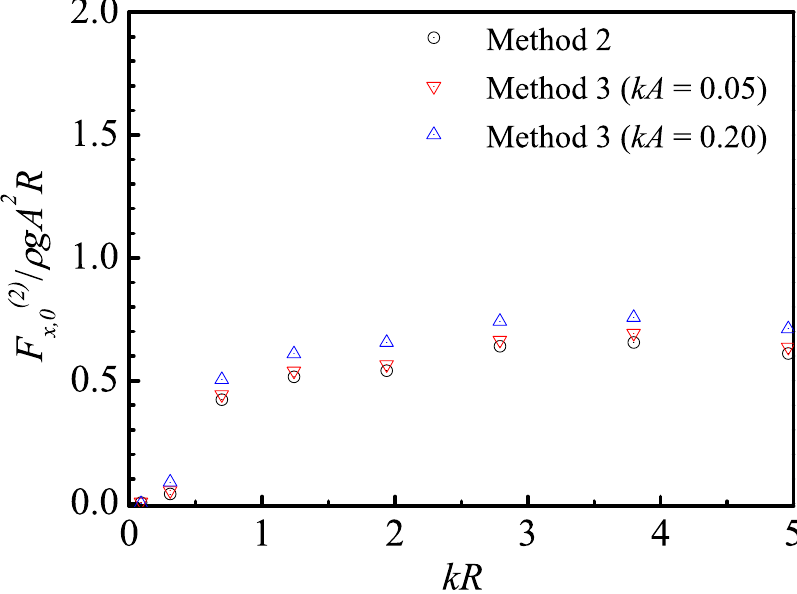
Figure 16. Horizontal mean-drift force of the 6MW spar-type